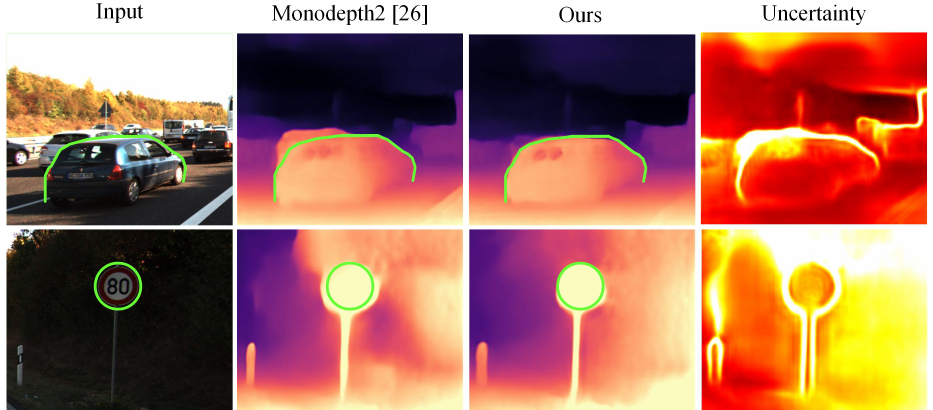
Figure 5. The case of depth estimation with edge optimization. In the case of object occlusion (white and black car in the above figure), monodepth2 predicts both as similar depths, and the silvery green in the figure is the front car outline. Our method correctly predicts the depth of the front car. For the object in the low-texture region (the road sign in the figure below), monodepth2 predicts the depth area pixel size not only larger than the pixel size in the original image but also a little blurred at the depth edge (the depth difference with the background is not obvious). Our method produces better results both in terms of pixel size and smoothness of